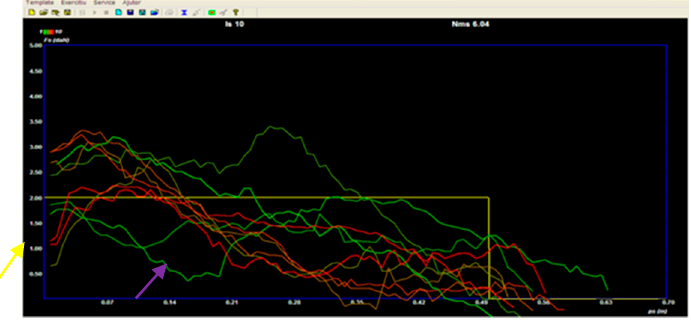
Figure 4. Visual–psychomotor scheme with real-time model tracking, Subject L.M. The ideal of motricity is to perform different movements with the same amplitude and direction on a predetermined volume and intensity with minimal energy